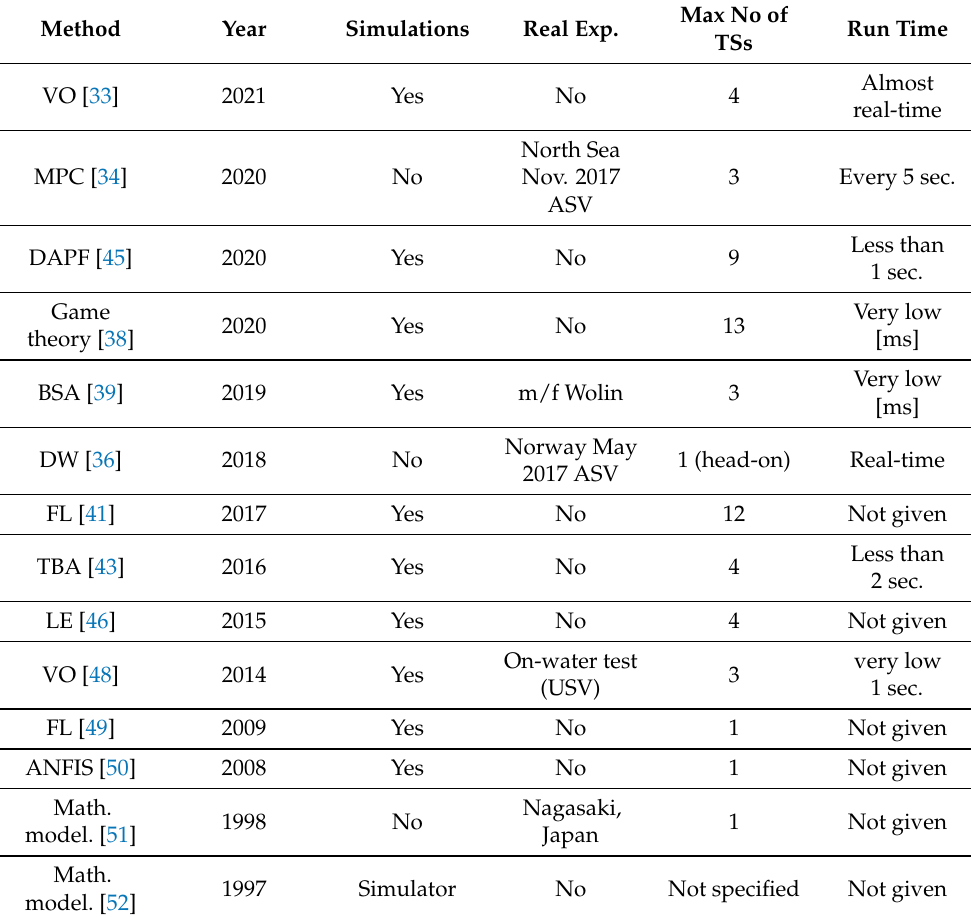
Table 5. A comparison of deterministic methods applying radar remote sensing and other sensors— part